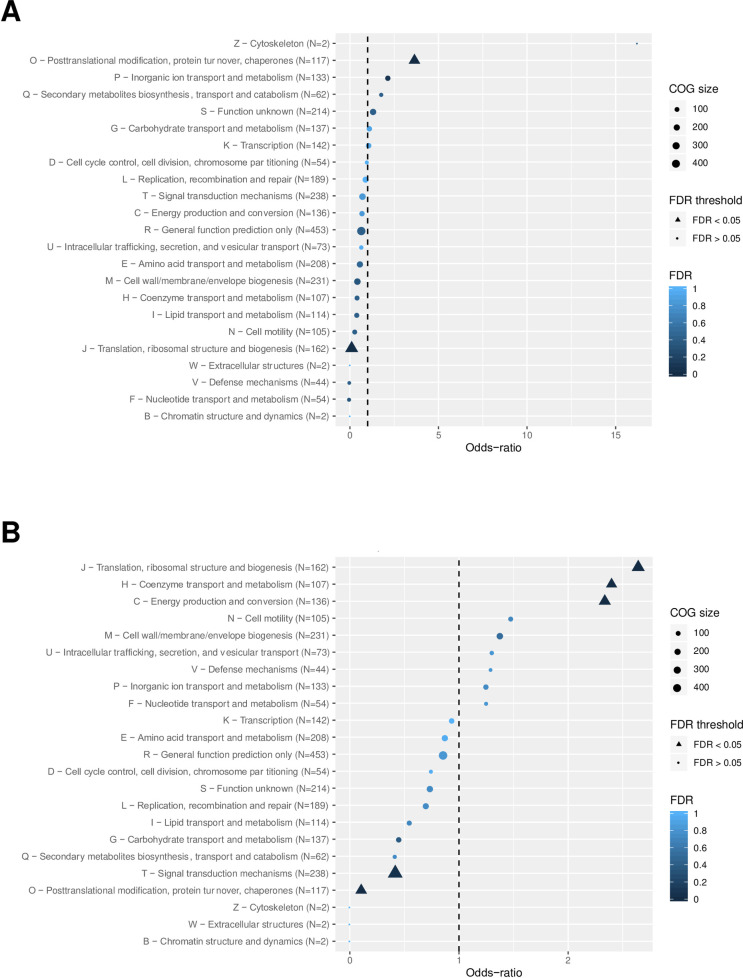
Classification of differentially-expressed genes upon exposure to lethal dose of hydrogen peroxide.ORFs with significantly changed expression when L. interrogans were exposed to 1 mM H2O2 for 1h were classified according to the COG (Clusters of Orthologous Groups). A Log2FC cutoff of ±1 were applied for the up-regulated (A) and down-regulated (B) ORFs, respectively, with an adjusted p-value<0.005. An odd-ratio higher or lower than 1 (dashed line) indicates an over- or under-representation of a functional category, respectively, and a COG category with a False Discovery Rate (FDR) lower than 5% is considered as enriched. The functional categories are indicated on the left.